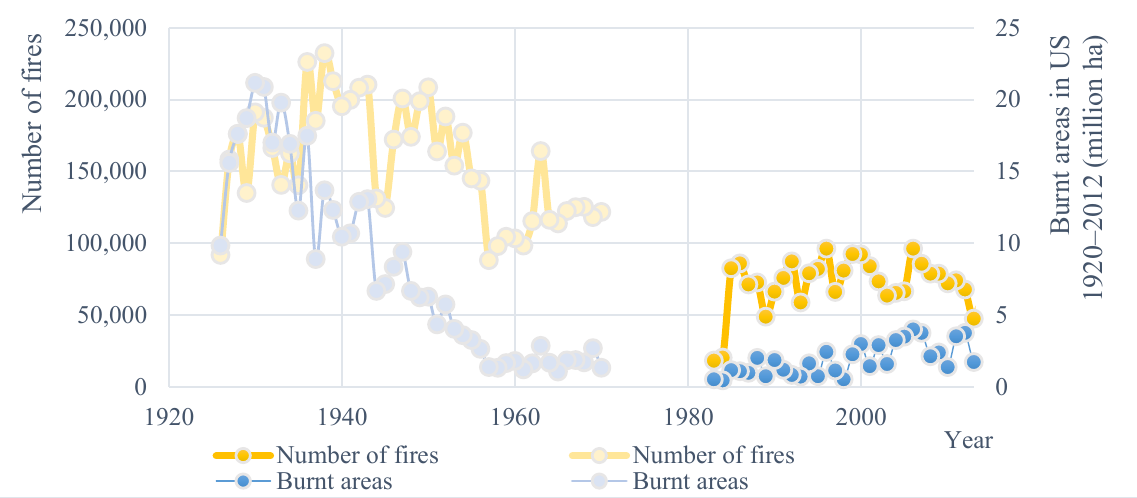
Figure 1. The evolution of wildfires in USA (1926–1970 and 1983–2021). Data before 1980 are impacted by larger uncertainty (lack of satellite vision) and are depicted in gray.